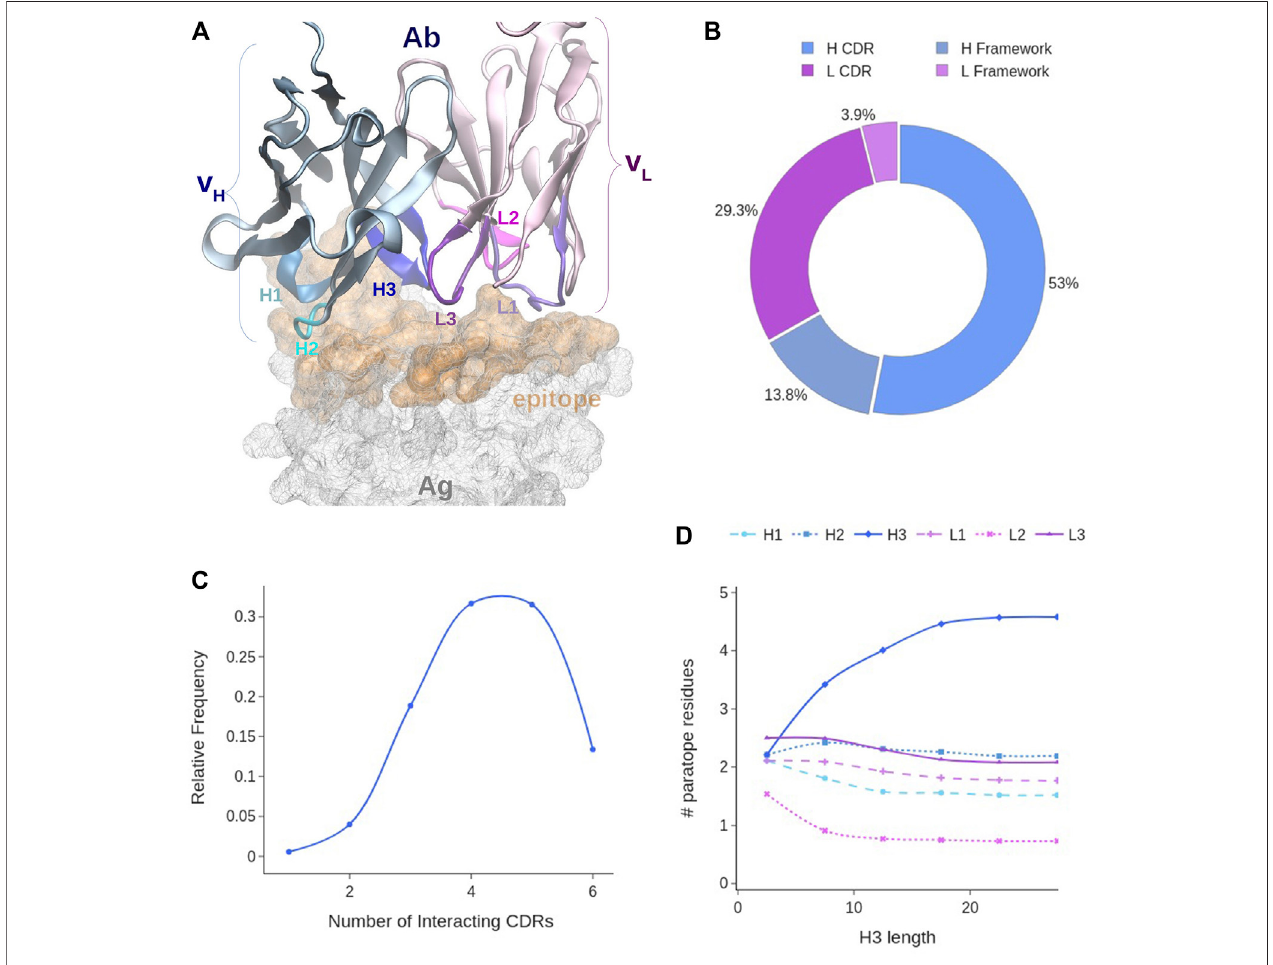
FIGURE3| Paratopeanalysis. (A) Covox-269Fab interacting withthereceptorbindingdomainofSARS-Cov-2 spikeprotein (PDB code:7NEH) asrepresentative structure of an Ab-Ag complex. (B) Distribution of paratope residues according to Ab chain type and CDR presence. (C) Distribution of CDRs in the paratope. (D) Distribution of paratope residues given the number of H3 residues. Color code: light chain elements (magenta), heavy chain elements (cyan).